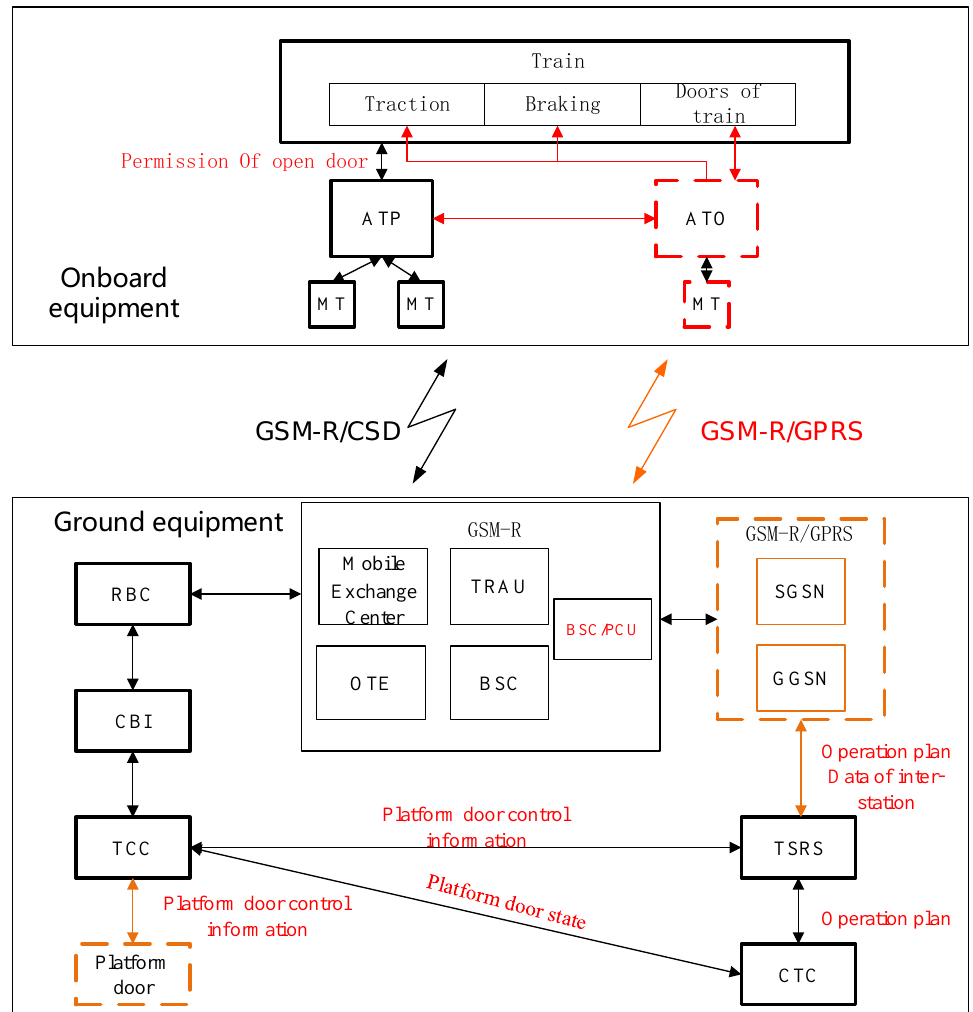
Figure 3. The interface schematic diagram of the ATO system. MT, Mobile Terminal; CBI, Computer Based Interlocking; OTE, Optical Transmission Equipment; TRAU, Transcoder and Rate Adaptor Unit; BSC, Base Station Controller; PCU, Process Control Unit; SGSN, Serving GPRS Support Node; GGSN, Gateway GPRS Support